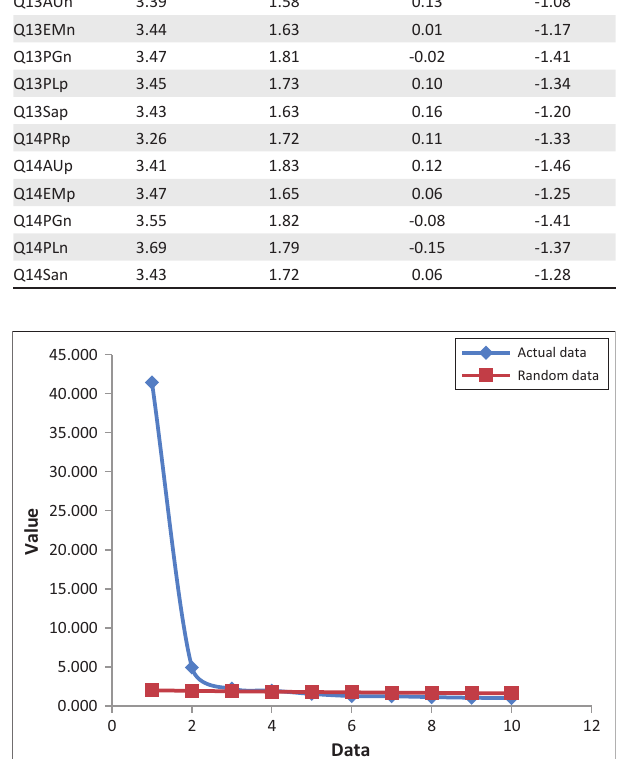
FIGURE 1: Scree and parallel analysis plot.